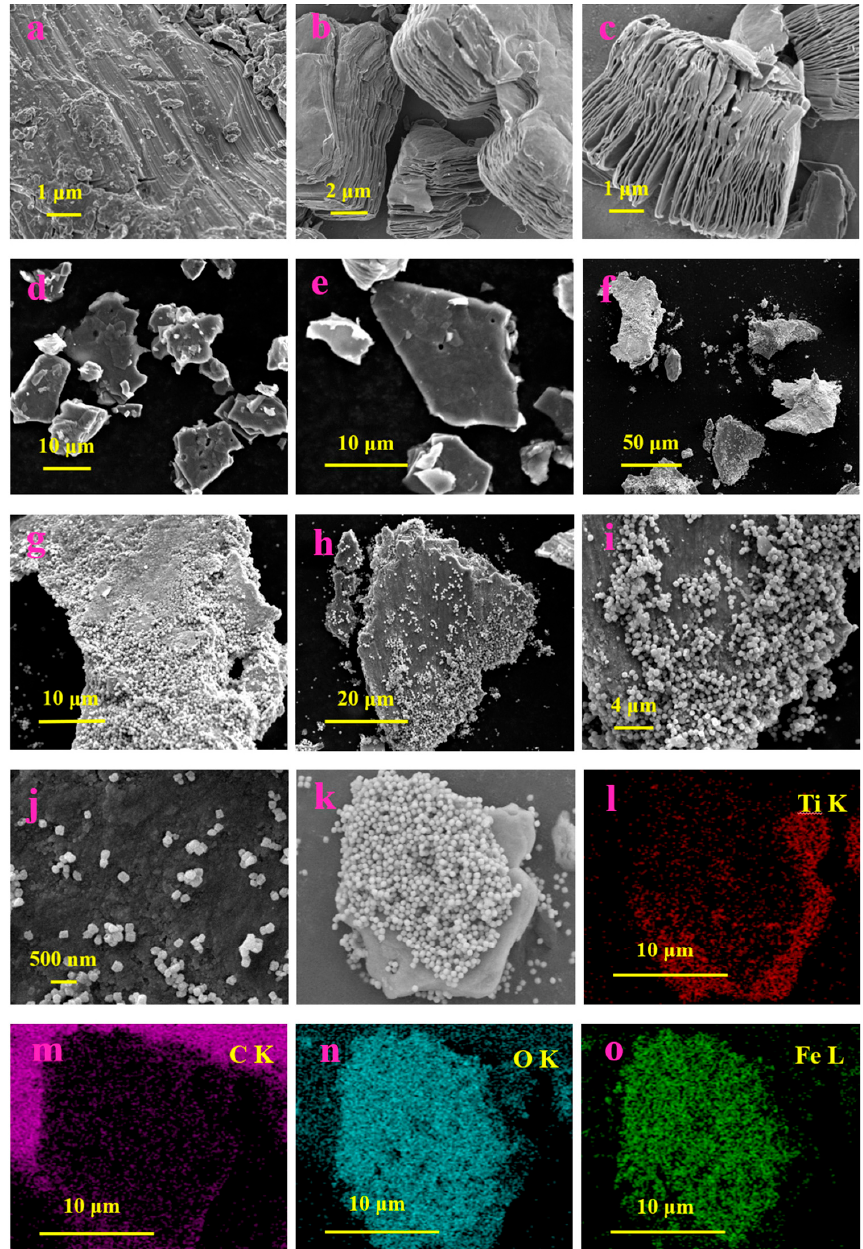
Figure 28. SEM images of ( a ) pristine MAX phase, ( b , c ) multilayer Ti 3 C 2 T x MXene, ( d , e ) sheet-like Ti 3 C 2 T x MXene, and ( f – j ) α -Fe 2 O 3 /Ti 3 C 2 T x MXene composites; ( k – o ) EDS elemental mapping micrographs of α -Fe 2 O 3 /Ti 3 C 2 T x MXene composites. Reprinted with permission from [136]. Copyright 2021: Elsevier B.V.